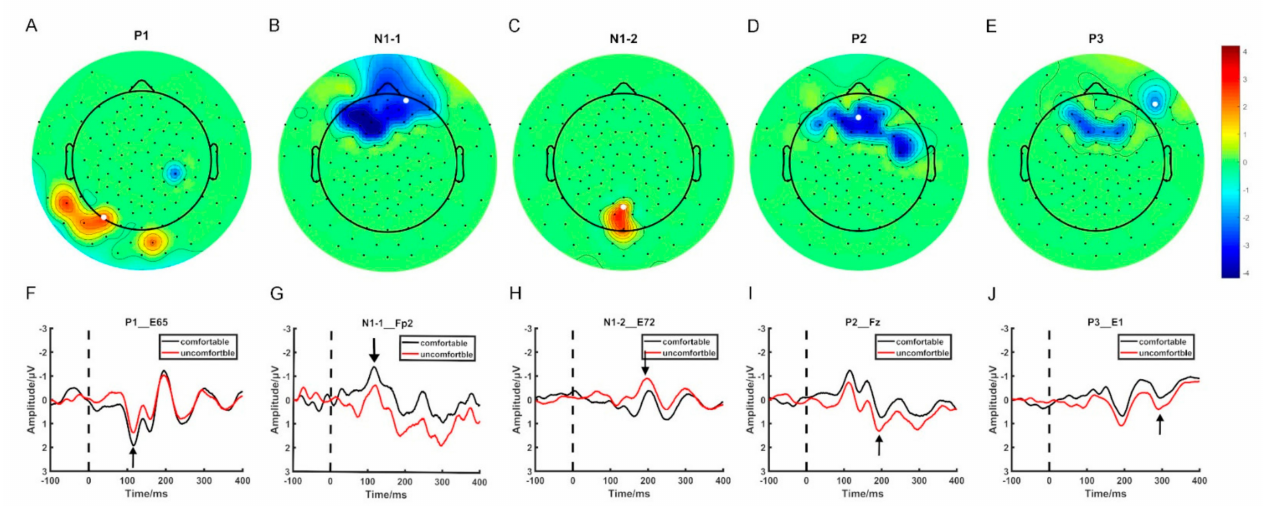
Figure 1. The spatial distribution of the selected electrodes. ( A – E ) The topographic map of the ERP components showing significant differences between visual comfort and discomfort. ( F – J ) The EPR waveforms of the selected